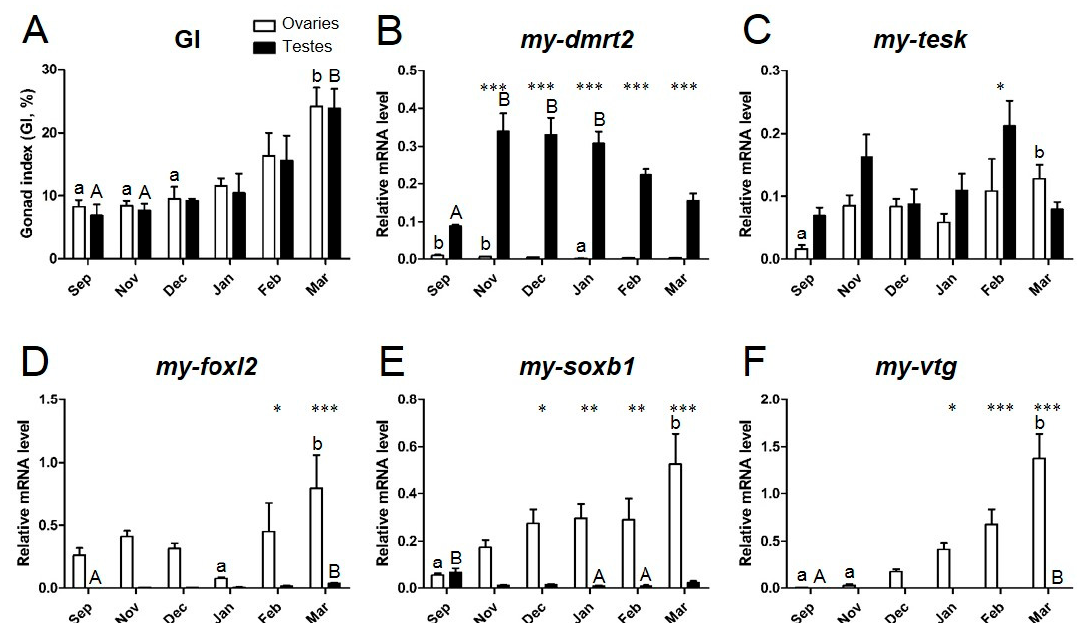
Figure 7. History of ( A ) GI and quantification of ( B ) dmrt2 , ( C ) tesk , ( D ) foxl2 , ( E ) soxb1 , and ( F ) vtg mRNAs in the gonads of the Yesso scallops throughout the reproductive cycle. White and black bars show the relative mRNA levels in testes and ovaries, respectively. Error bars show SEM at each sampling point ( n = 5 for each sex). Different superscript letters indicate significant differences within sex (lower case for ovaries and upper case for testes). Asterisks *, **, and *** indicate significant differences between testes and ovaries at p < 0.05, p < 0.01, and p < 0.001, respectively.